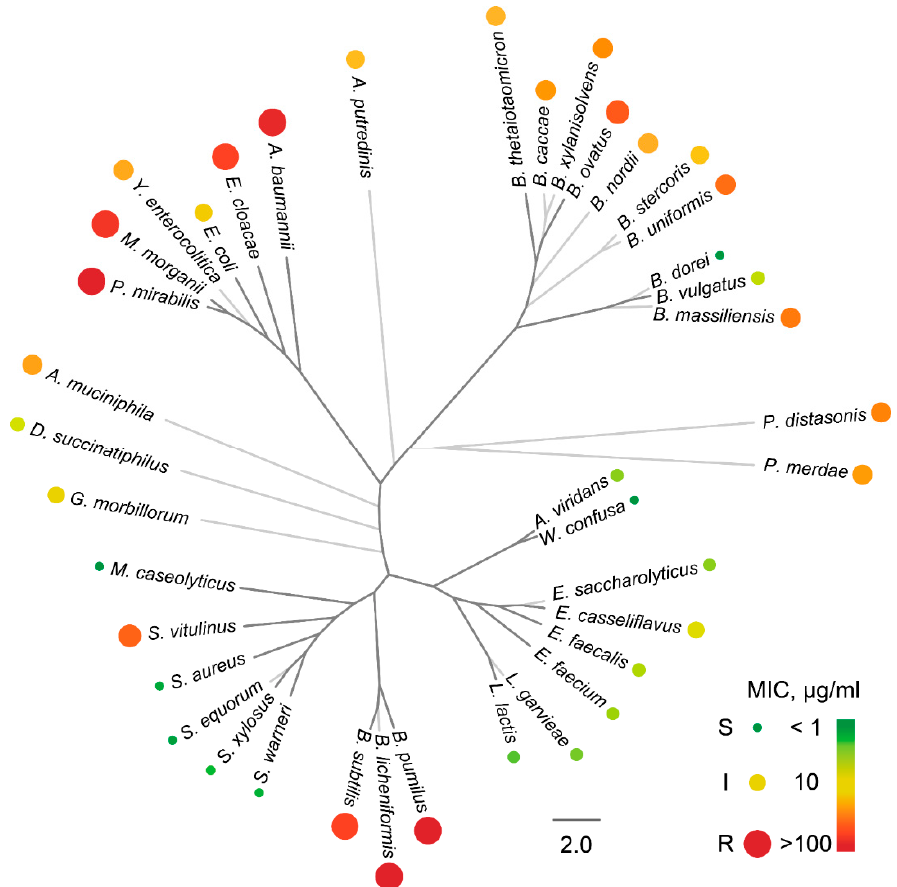
Figure 4. Comprehensive overview of Ami activity spectrum. The phylogeny of bacteria is presented with the respective mean minimum inhibitory concentrations (MICs). The color and area of circle markers indicate the average MIC value. Sensitive, intermediate, and resistant bacteria are indicated according to the color bar and marked as S, I, and R, respectively. The phylogenetic tree was reconstructed based on 16S rRNA. Bacteria analyzed solely using a bioinformatics-based deep functional profiling approach and not confirmed by standard cultivation assays are colored in light gray.